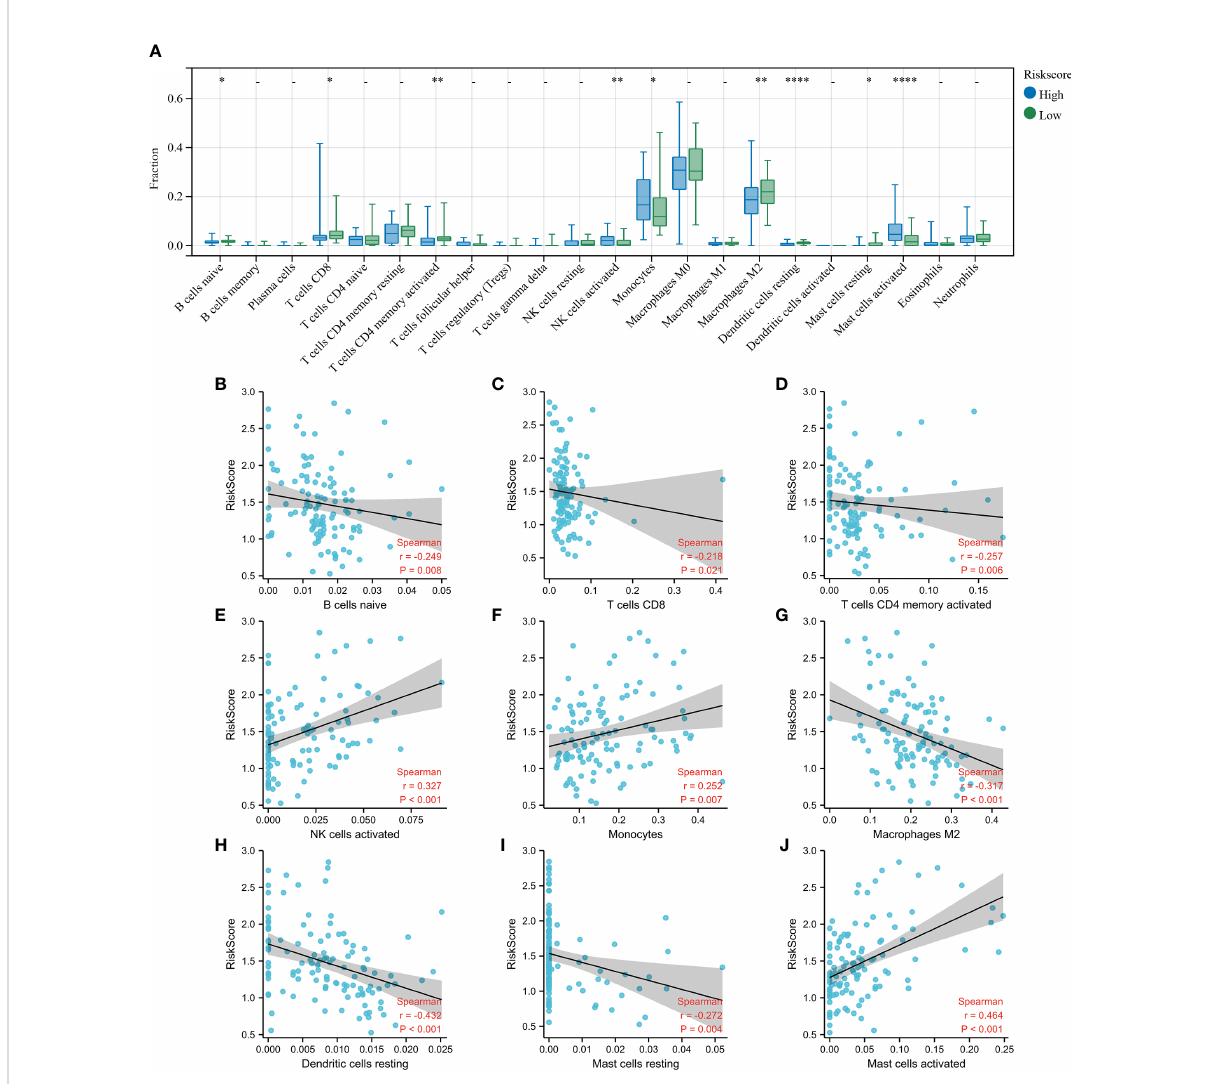
FIGURE 6 Estimation of immune cell in fi ltration in the bronchoalveolar lavage fl uid (BALF). (A) Level of in fi ltration in the high- and low- Riskscore groups using the CIBERSORT algorithm. The plots show the differences in immune in fi ltration scores between the high- and low- Riskscore groups. (B – J) The Spearman ’ s rank correlation between Riskscore and the fraction of BALF immune cells is shown. Scatterplots show that the Riskscore negatively correlated with naive B cells (B) , CD8 T cells (C) , activated memory CD4 T cells (D) , M2 macrophages (G) , resting dendritic cells (H) , and resting mast cells (I) , while Riskscore positively correlated with activated NK cells (E) , monocytes (F) , and activated mast cells (J) . *p < 0.05; **p < 0.01; and ****p <